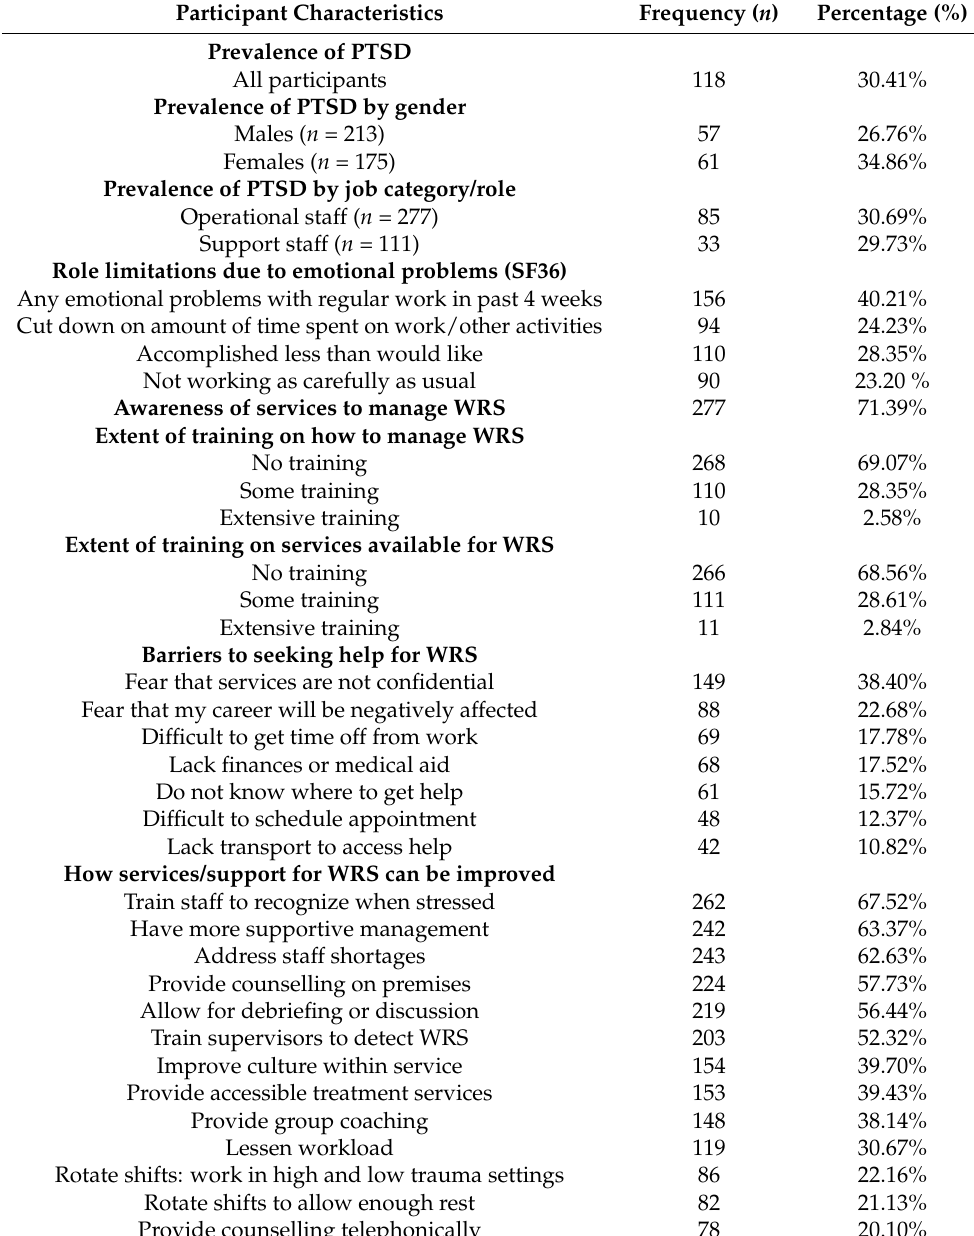
Table 3. Frequency and distribution of mental health specific variables ( n =